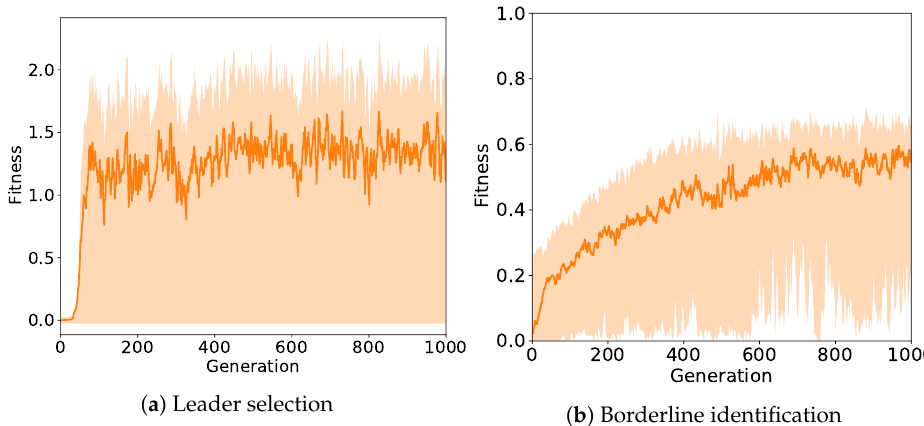
Figure 3. Evolution of the fitness function with the generations of SNES in ( a ) the leader selection and ( b ) the border identification tasks. In each generation, the darker curves are the sample mean fitness scores and the upper and lower contours of the shadow areas represent the maximum and minimum fitness